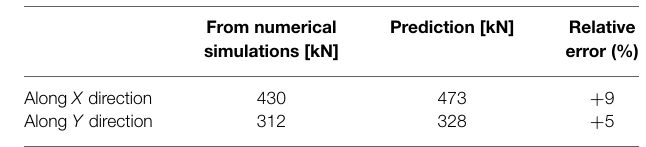
TABLE 6 | Maximum damper forces in the non-linear dampers (MCEER procedure) .